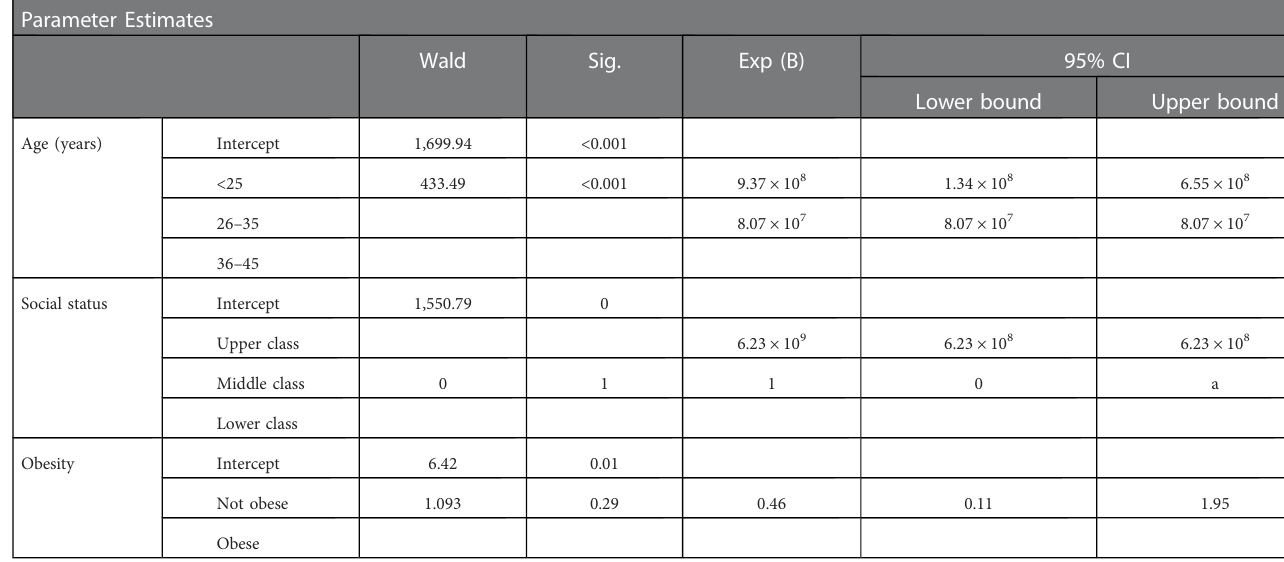
TABLE 8 Multinominal analysis of sociodemographic variables on type of recurrent pregnancy